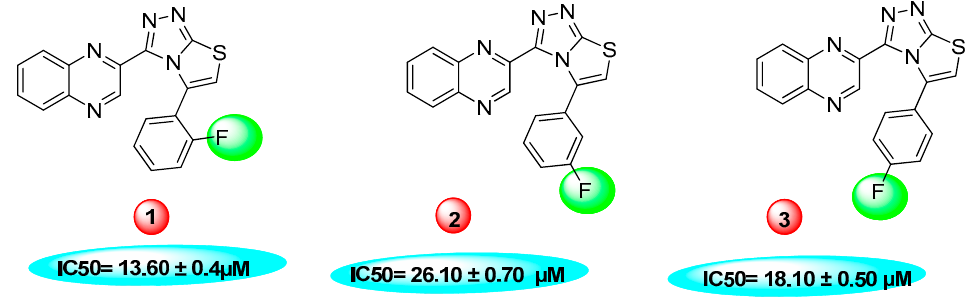
Figure 3. Activity of fluorine substitutions at different positions.